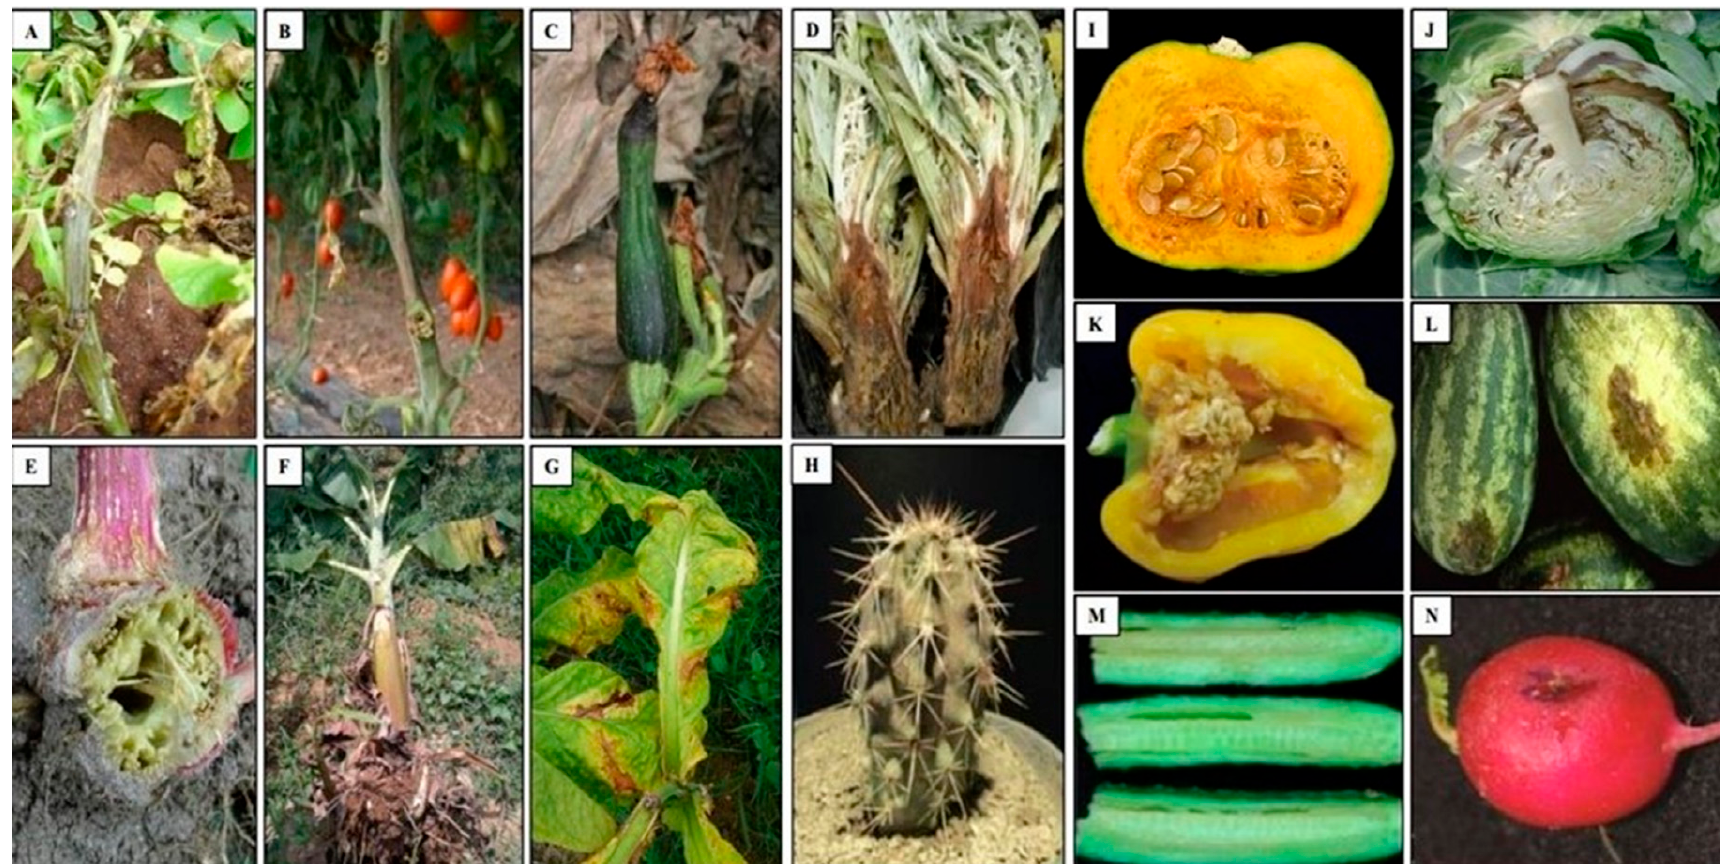
Figure 3. Symptoms caused by Pbr in several plant species. ( A ) Potato ( S. tuberosum ), ( B ) Tomato ( Solanum lycopersicum ), ( C ) Zucchini ( Cucurbita pepo ), ( D ) Artichoke ( Cynara cardunculus var. scolymus ), ( E ) Amaranth (Amaranthus), ( F ) Banana ( Musa sp.), ( G ) Tobacco ( Nicotiana tabacum ), ( H ) Tetecho ( Neobuxbaumia tetetzo ), ( I ) Squash ( Cucurbita pepo ), ( J ) Cabbage ( Brassica oleracea ), ( K ) Pepper ( Capsicum annuum ), ( L ) Watermelon ( Citrullus lanatus ), ( M ) Cucumber ( Cucumis sativus ), ( N ) Raphanus ( Raphanus sativus ) [6,7,63,64,82,85–87].